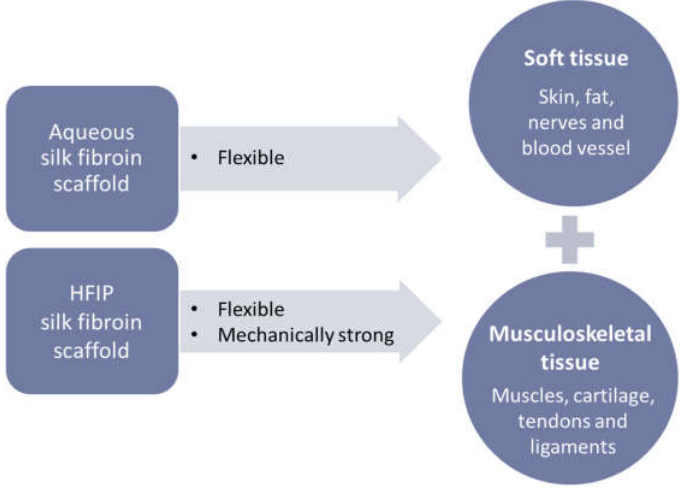
Figure 9. A schematic diagram of the application of SF scaffolds for tissue regeneration.